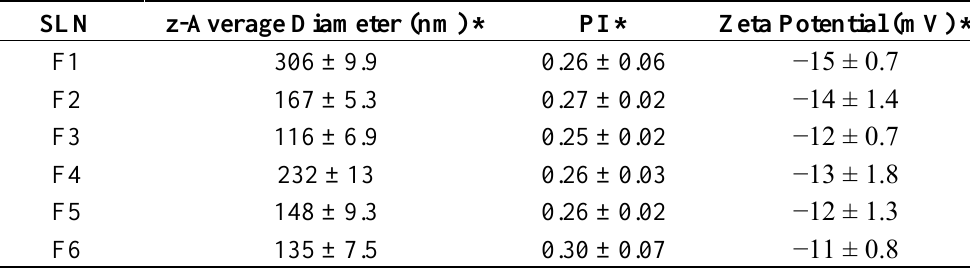
Table 2. Characteristics of SLNs: particle size, PI and zeta